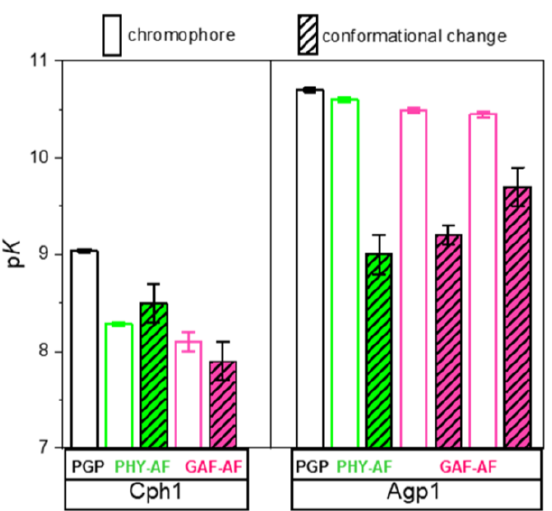
Figure 8. Comparison between chromophore p K a and pH-dependent conformational change in the PHY and GAF domain for Cph1 and Agp1. Data from Figure 7, Table 3 and reference [13]. Table 2. Time-resolved anisotropy fit results of Agp1-PGP-AF variants. WT-AF (A), C279-AF (B), C295-AF (C), V364C-AF (D). r 0 is the initial anisotropy and the amplitudes β 1 and β 2 indicate the